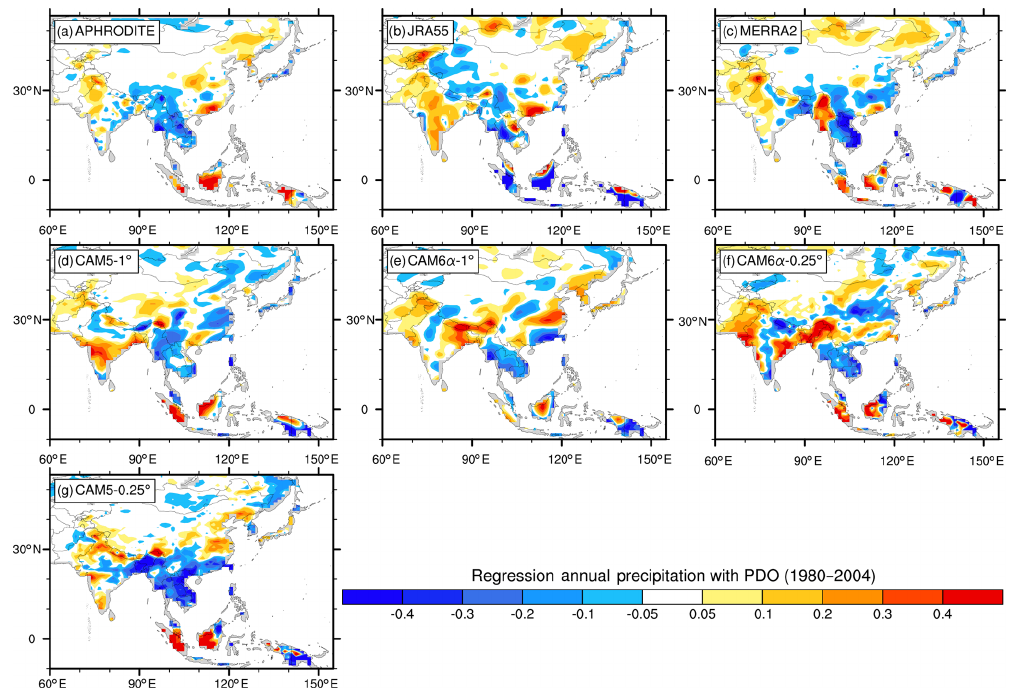
Figure 6. Regression of annual mean precipitation (mmd − 1 ) onto observed PDO indices for